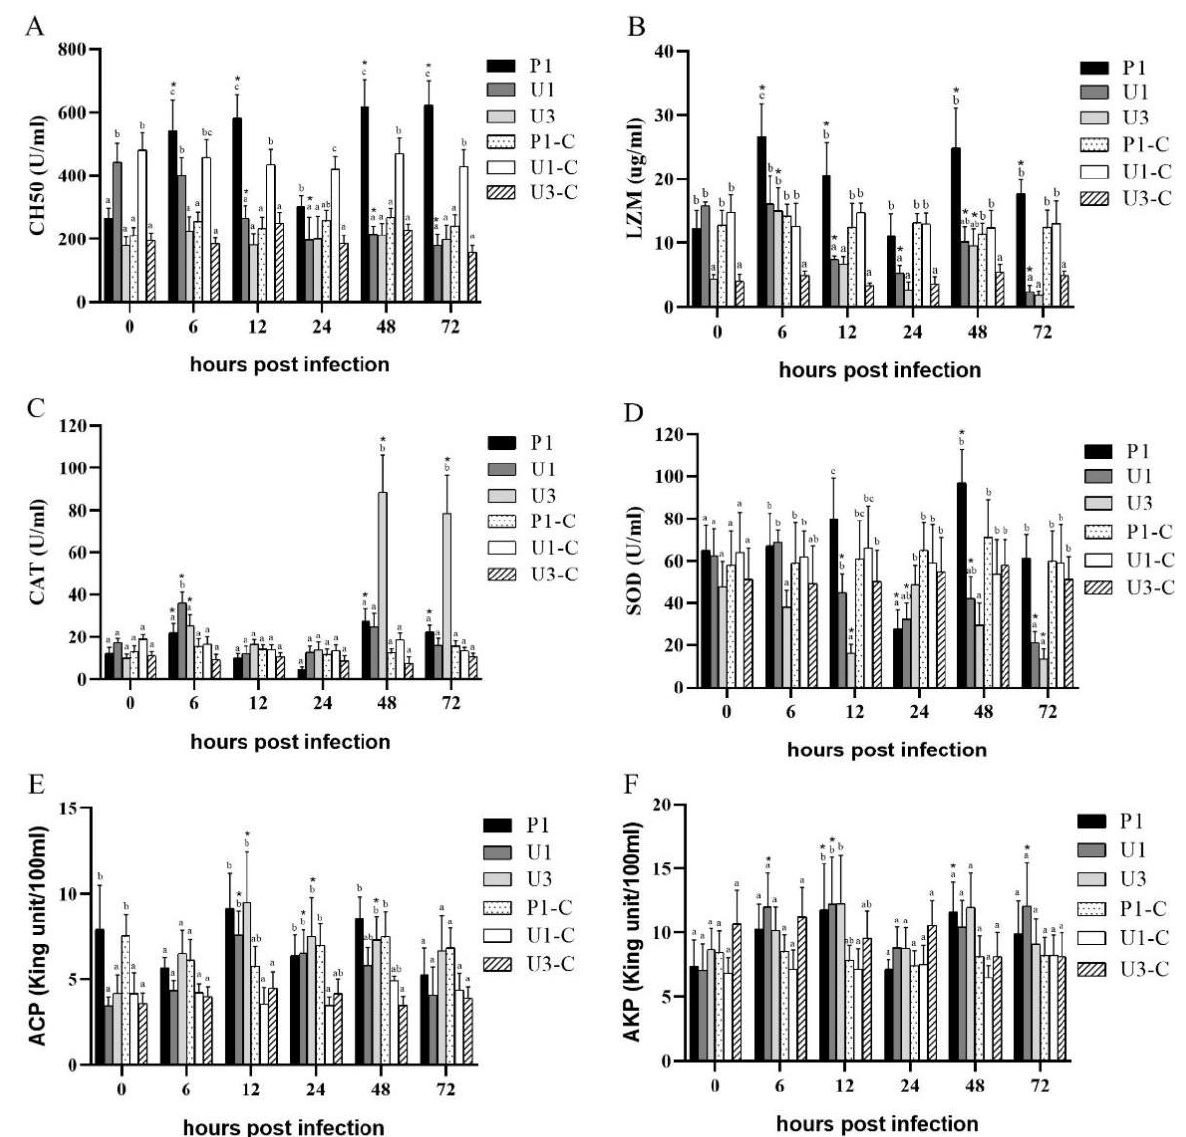
Figure 2. Activities of total complement CH50 ( A ), lysozyme ( B ), catalase ( C ), superoxide dismutase ( D ), acid phosphatase ( E ), and alkaline phosphatase ( F ) in the serum of largemouth bass in the P1, U1, and U3 groups infected with MSRV, and P1-C, U1-C, and U3-C groups injected with PBS. Different letters indicate significantly different between different groups at the same sampling time ( p < 0.05). * Indicate significantly different between 0 h and other sampling time of the same group ( p < 0.05).